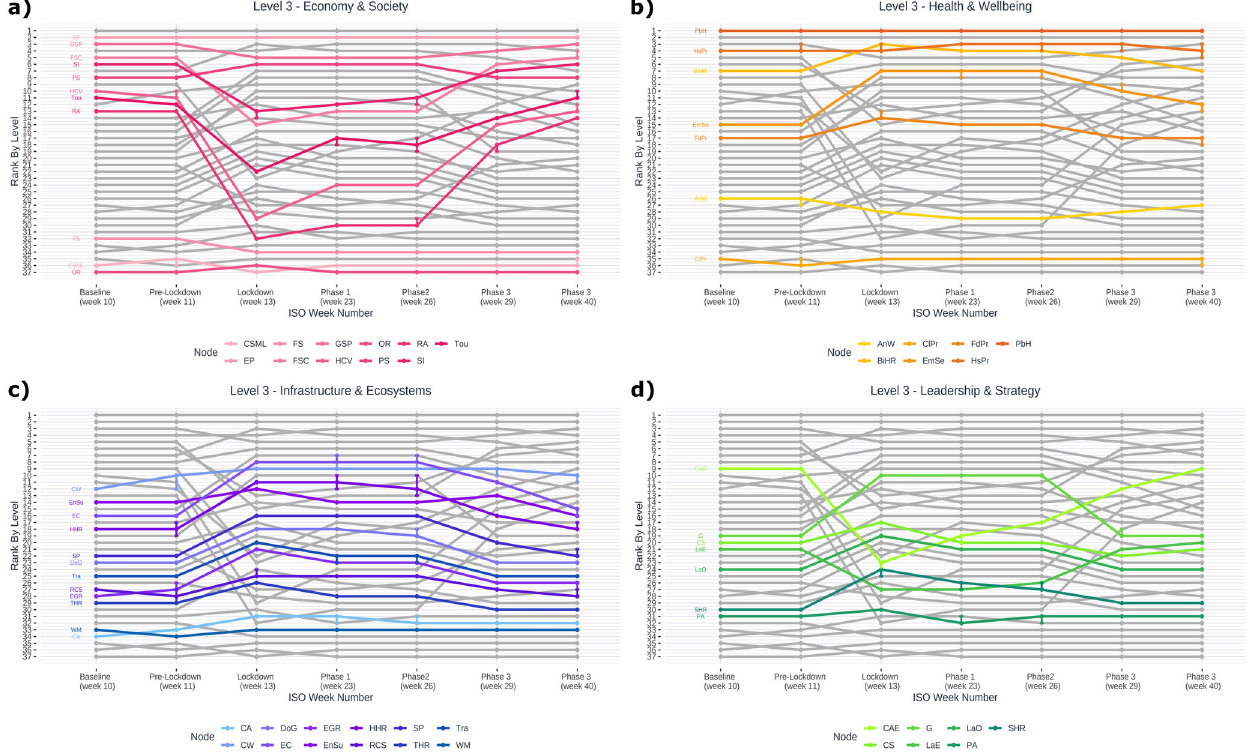
Fig. 10 Rank changes in tasks at key phase changes throughout the modelled period (rank con fi dence included – see “ Methods ” section). Rank changes in the a economy & society category, b health & wellbeing category, c infrastructure & ecosystems category, d leadership & strategy category (for full node names and abbreviations see Fig. 9 or Table